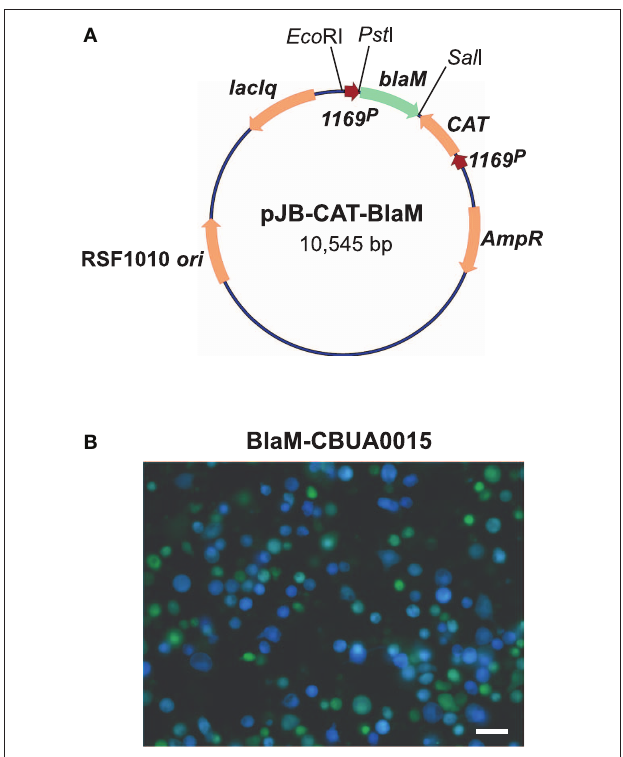
Figure 3 | A C. burnetii BlaM translocation assay shuttle vector. (A) Map of the reporter plasmid pJB-CAT-BlaM which contains an RSF1010 ori that functions in both E. coli and C. burnetii. Genes encoding suspected secreted proteins are cloned downstream and in-frame with blaM using the unique SalI site. (B) BlaM translocation assay showing cytosolic delivery of a BlaM- CBUA0015 fusion protein. THP-1 cells were infected with C. burnetii Nine Mile (phase II) containing pJB-CAT-BlaM::CBUA0015 for 48 h, then incubated for 1 h with CCF4/AM. Cleavage of CCF4/AM by cytosolic BlaM results in blue fluorescent cells and indicates secretion of the fusion protein. Bar, 30